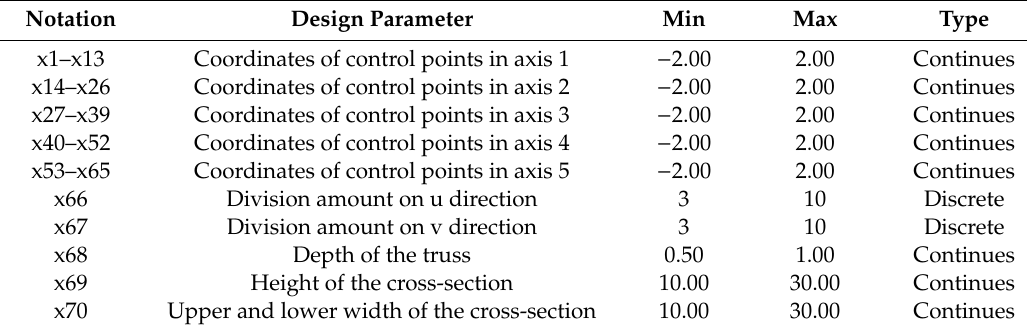
Table 3. Properties of design parameters.